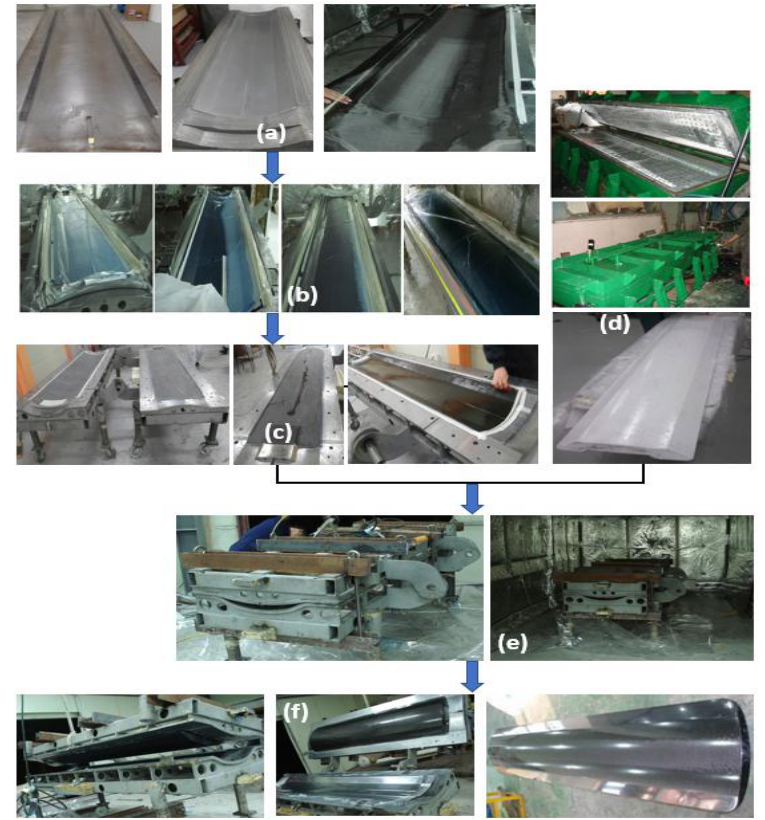
Figure 10. Manufacturing Process of Sandwich cradle; ( a ) preparing mold & layup of carbon fiber, ( b ) resin infusion, ( c ) curing the faces & apply the resin evenly, ( d ) prepared core, ( e ) inserting core into molds and curing/bonding, ( f ) de-molding and hole